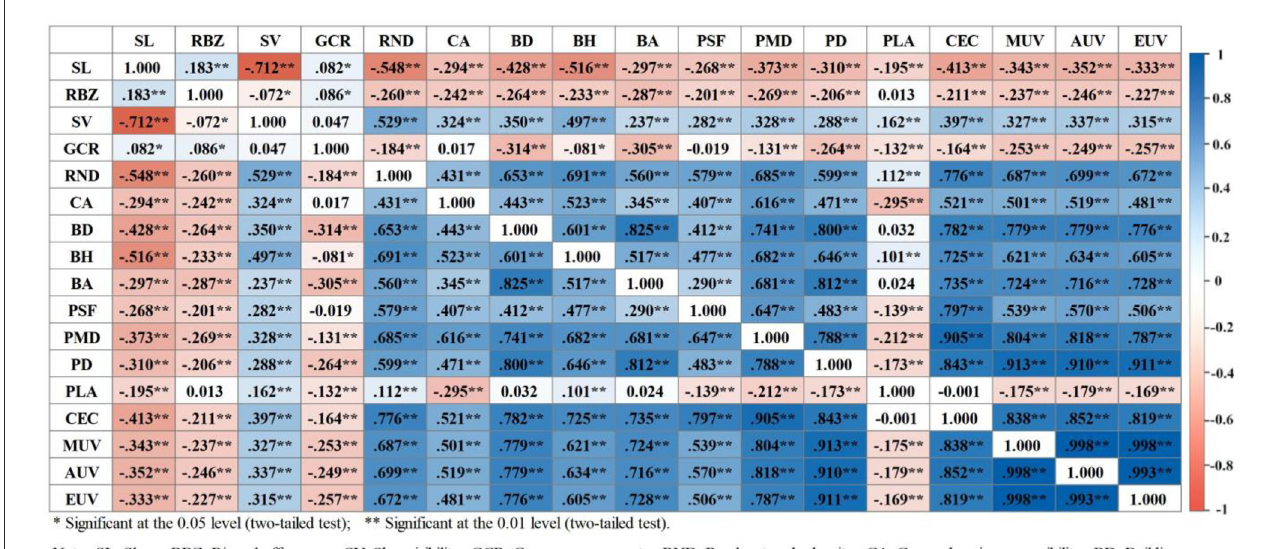
FIGURE6 Pearson correlation between objective environmental comfort factors and urban vitality. *Significant at the 0.05 level (two-tailed test); **Significant at the 0.01 level (two-tailed test). SL, Slope; RBF, River buffer zone; SV, Sky visibility; GCR, Green coverage rate; RND, Road network density; CA, Comprehensive accessibility; BD, Building density; BH, Building height; PSF, Density of public service facilities; PMD, POI mixing degree; PLA, Per capita living area; CEC, Comprehensive environmental comfort; MUV, Morning urban vitality; AUV, Afternoon urban vitality; EUV, Evening urban vitality.